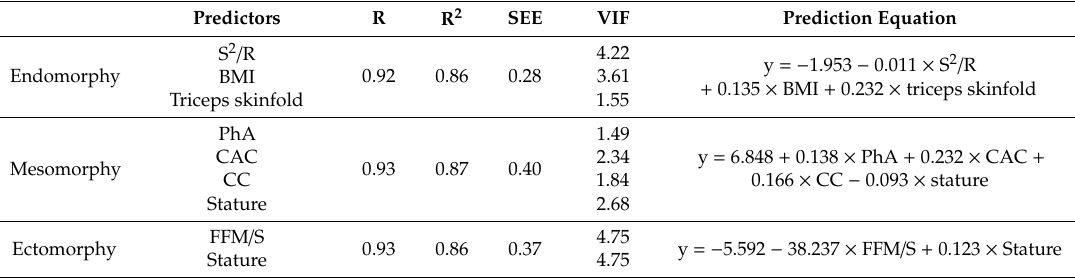
Table 2. Prediction Models for Endomorphy, Mesomorphy, and Ecthomorphy Based on Anthropometrics and Bioimpedance-Derived Variables.